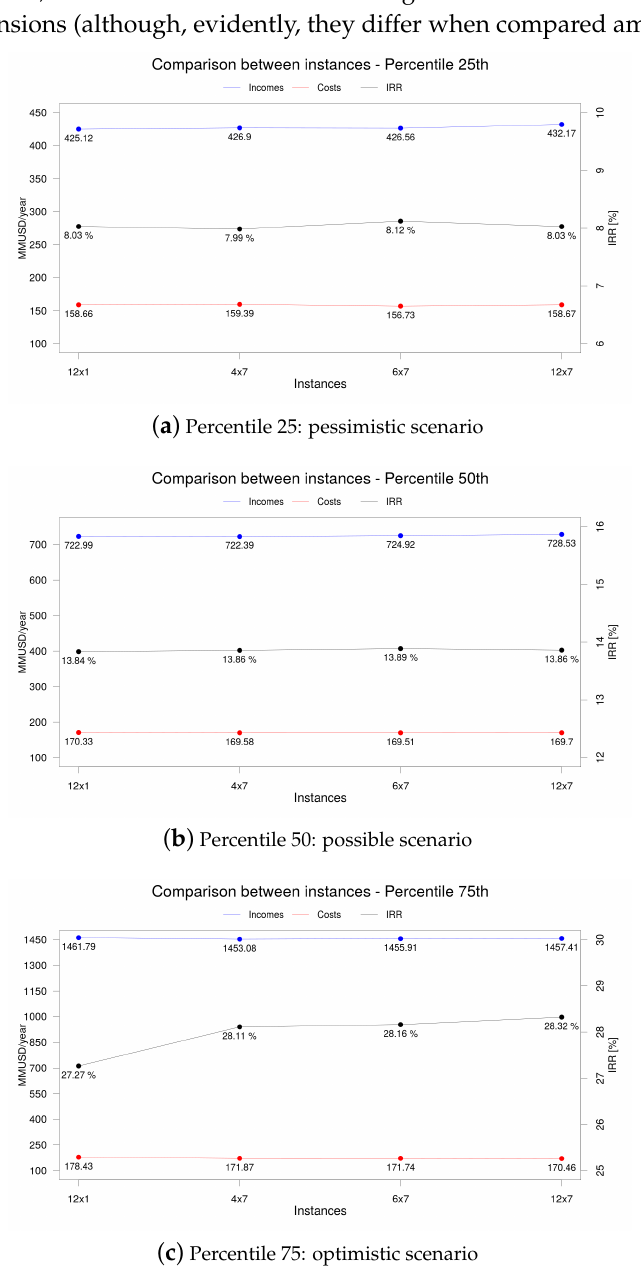
Figure 10. Comparison between economical indicators attained for different time resolution structures and scenarios. ( a ) Percentile 25; ( b ) Percentile 50; ( c ) Percentile